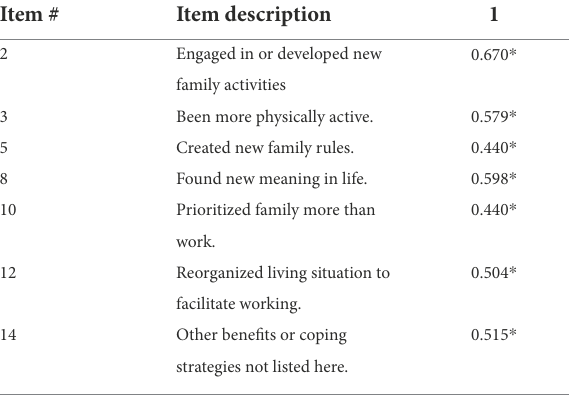
TABLE 2 Exploratory Factor Analysis One-Factor Solution (Geomin Rotated Loadings).